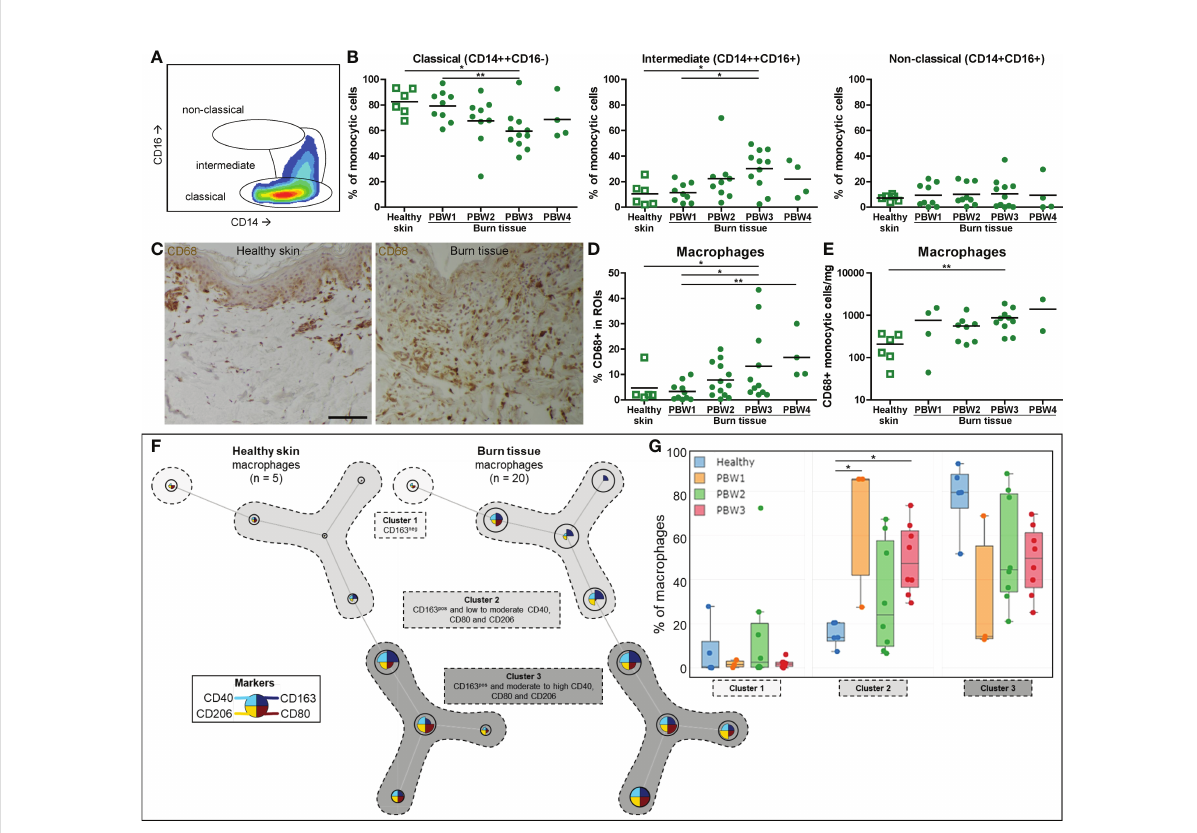
FIGURE 3 Local macrophage response to burn injury. (A) Flow cytometry gating strategy for detection of differentiation stages of monocytic cells (classical, intermediate or non-classical, as based on CD14 and CD16). (B) Flow cytometry-based quanti fi cation of percentage of monocytic cells within classical, intermediate, non-classical gates. (C) CD68 immunohistochemical DAB staining of a representative section of healthy skin and burn tissue (from 15 days post burn) (black scale bar = 100 µm). (D) CD68 + area of tissue sections. (E) Flow cytometry-based quanti fi cation of absolute number of macrophages (CD68 + monocytic cells) per mg tissue. (F) Unsupervised clustering of macrophages (CD68 + monocytic cells) in healthy skin and burn tissue, 3 clusters are highlighted. Node size represents relative size of population and node diagram shows expression level of markers. (G) Percentage of macrophages (CD68 + monocytic cells) within each cluster. Error bars in G show boxplot, p values were calculated using Mann-Whitney U statistical tests, signi fi cant differences are indicated by black asterisks: *p < 0.05; **p <